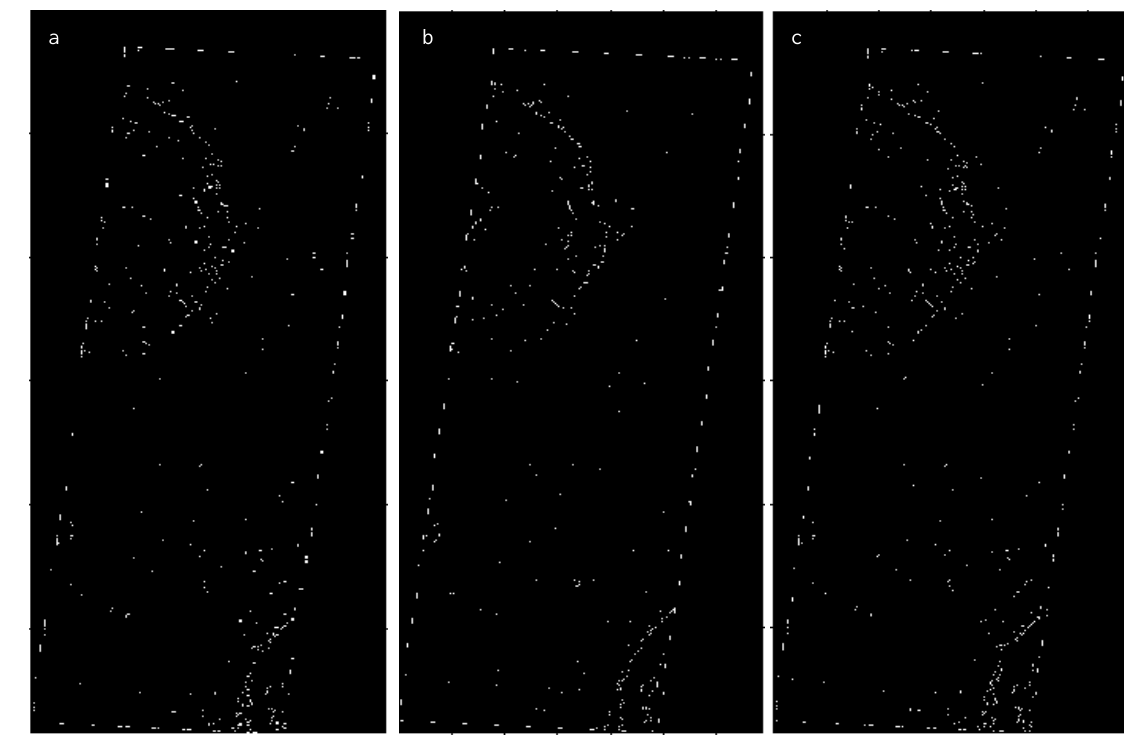
Figure 6. Edges for test case 2 by a) Sobel method b) Roberts method c) Prewitt